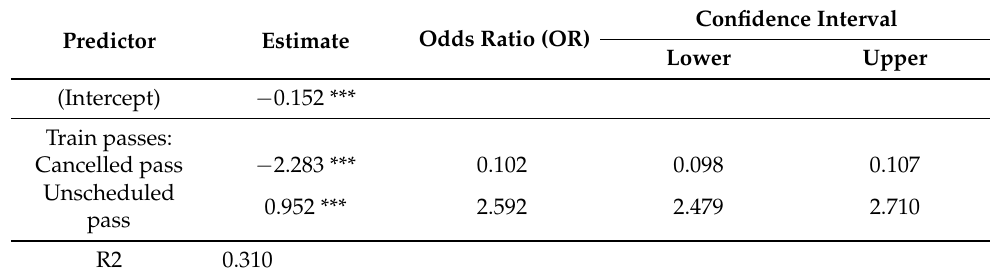
Table 2. Summary of logistic regression